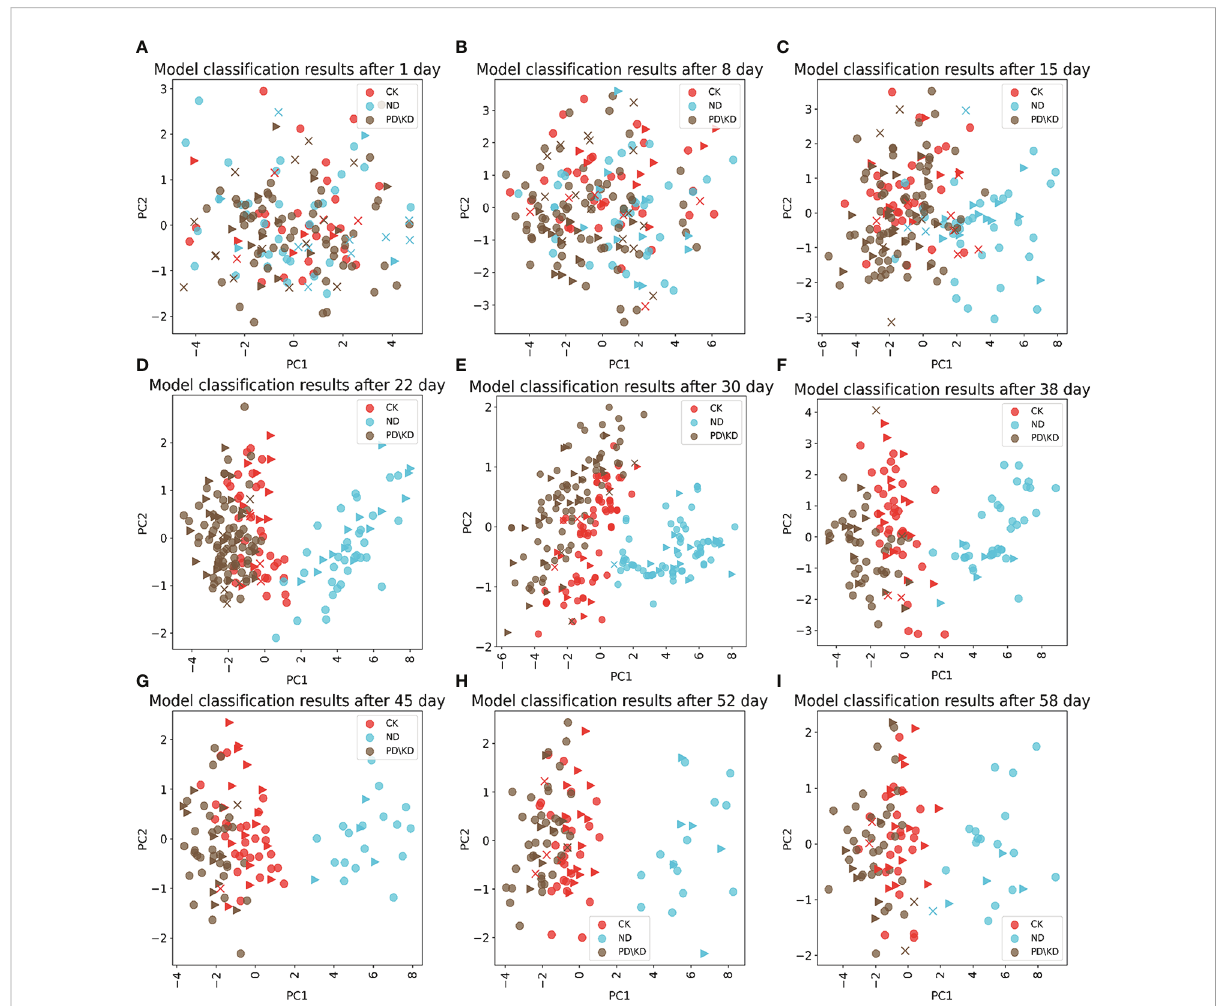
FIGURE 7 Classi fi cation results of logistic regression(LR) models under different stress time models. PCA dimensionality reduction and visualization of sample data collected at 5 m height. (A-I) were the classi fi cation results after 1, 8, 15, 22, 30, 38, 45, 52 and 58 days of stress successively. The LR algorithm predicts the test samples. ▼ are the correctly predicted samples in the test set, × are the incorrectly predicted samples in the test set, and (cid:129) are the training set